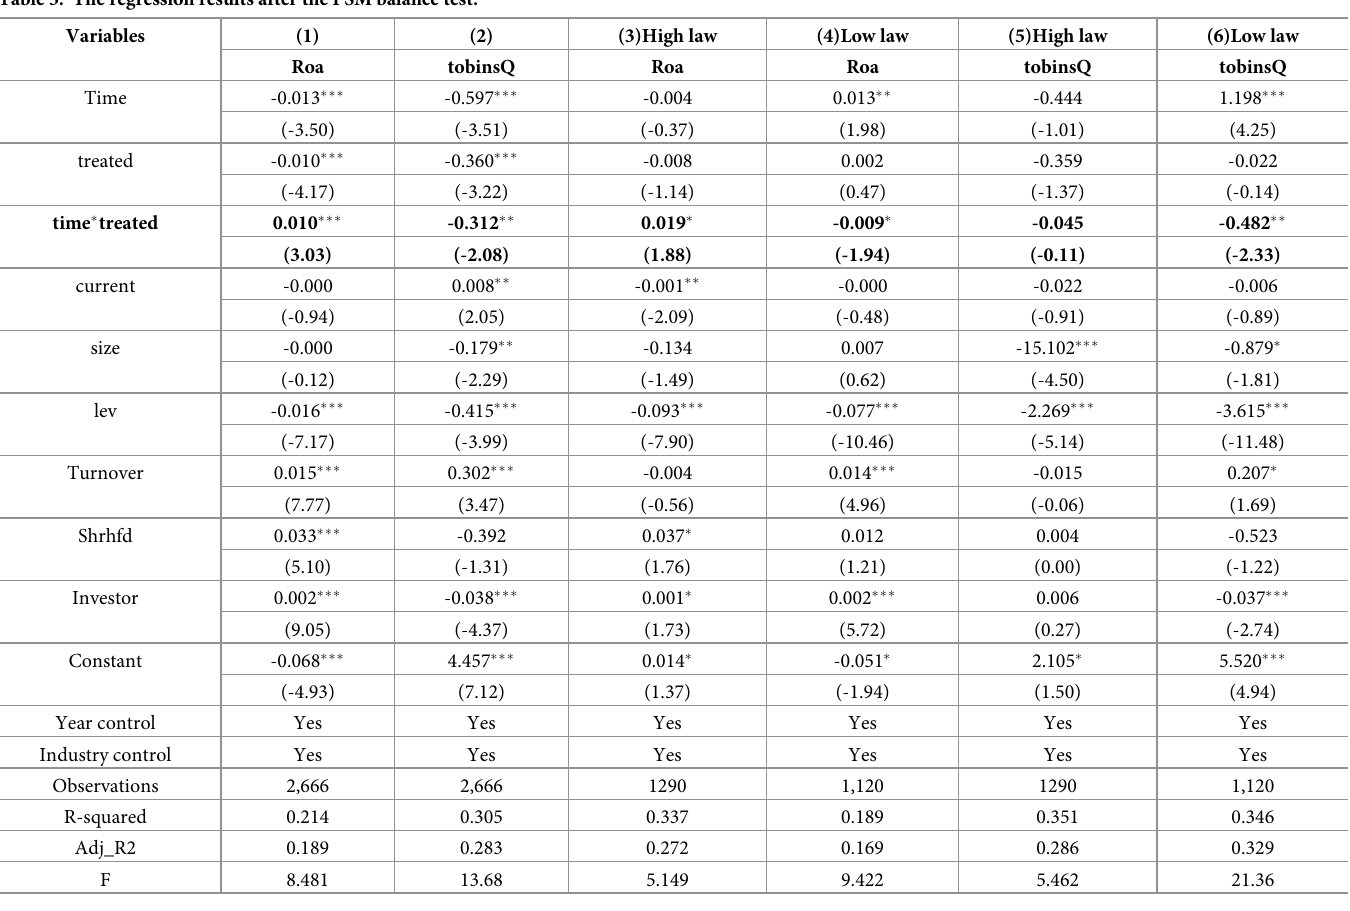
Table 5. The regression results after the PSM balance